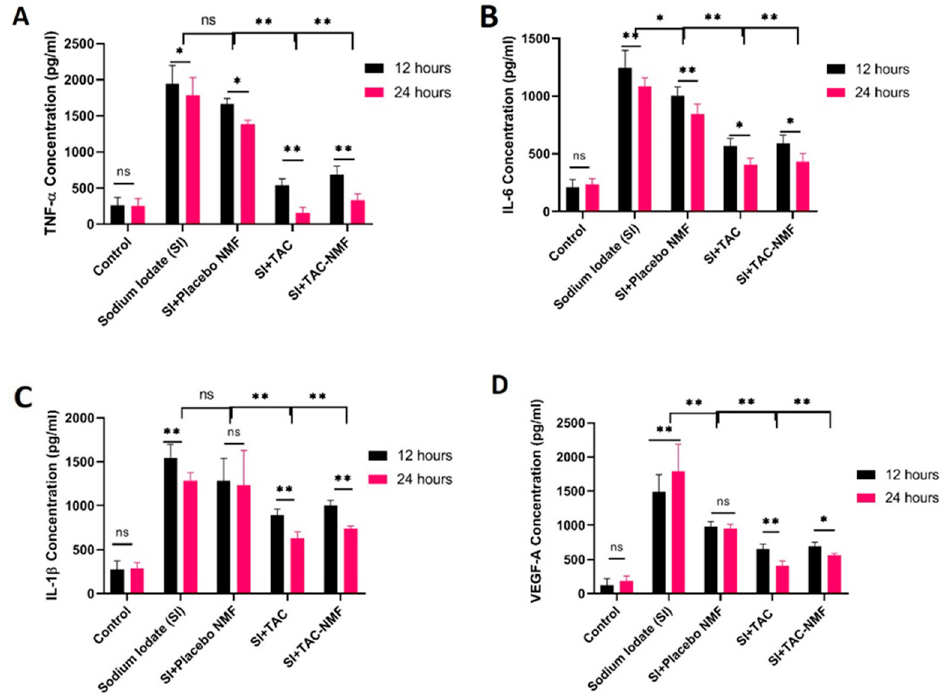
Figure 16. In-vitro release of TNF- α ( A ), IL-6 ( B ), IL-1 β ( C ) and VEGF-A ( D ) from D407 cells after treatment with Sodium Iodate (SI) for 6 h following 12 and 24 h exposure of TAC drug, placebo NMF and TAC-NMF using ELISA. (* p ≤ 0.05, ** p ≤ 0.01, ns = not significant as compared to the corresponding control group, here 12 h TNF- α release, 12 h IL-6 12 h IL-1 β and 12 h VEGF-A release).